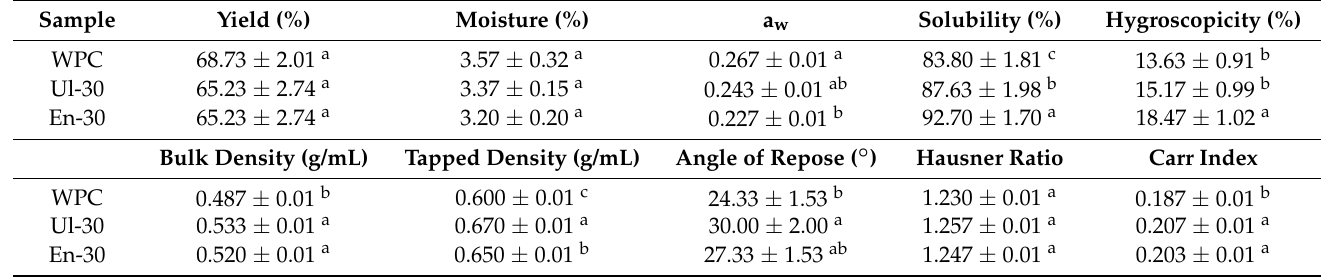
Table 3. Physicochemical and techno-functional properties of spray dried grape seed oil powders.